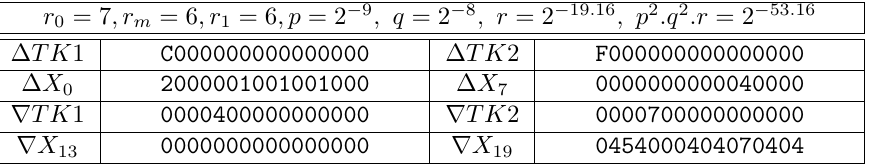
Table 10: Specification of boomerang distinguisher I for 19 rounds of SKINNY